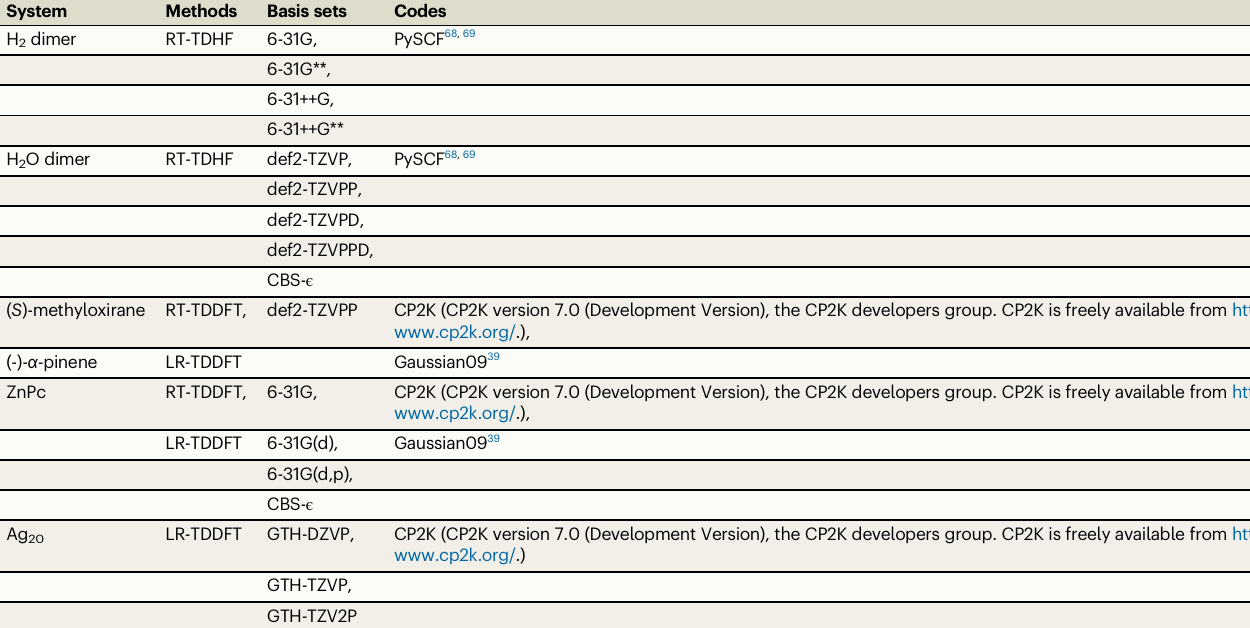
Table 4 | Systems and corresponding computational details System